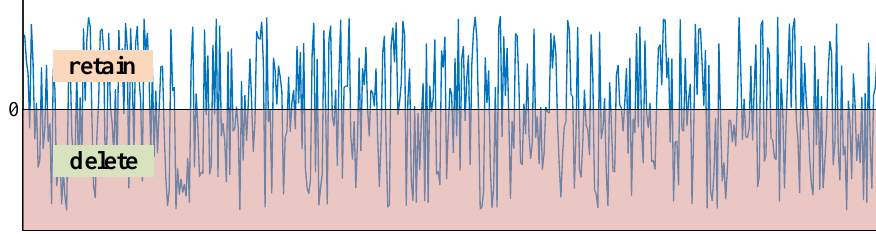
Figure 10. ReLU function when b = 0.